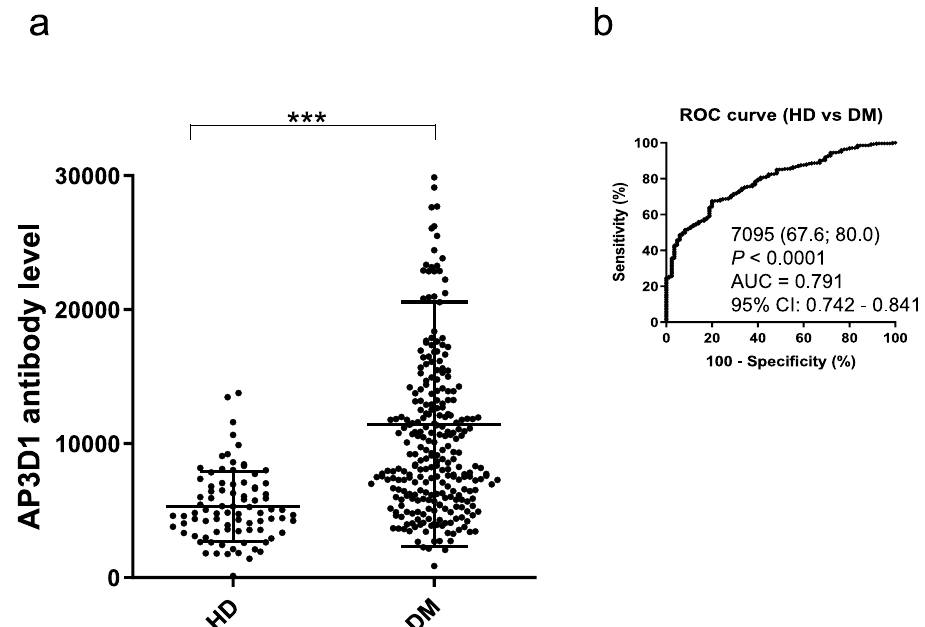
Figure 2. Comparing the levels of serum antibodies against AP3D1 between HDs and patients with DM. The s-AP3D1-Abs levels in HDs and patients with diabetes mellitus (DM) examined using AlphaLISA are shown ( a ). The bars represent the average and average ± SD. P -values were calculated using the Mann–Whitney U test. *** P < 0.001. The data are summarized in Table 2. ROC curves to assess the ability of s-AP3D1-Abs to predict DM are shown ( b ). The numbers in the figures are the same as those shown in Fig. 1. The results of the power calculation were shown in Supplementary Table S3.